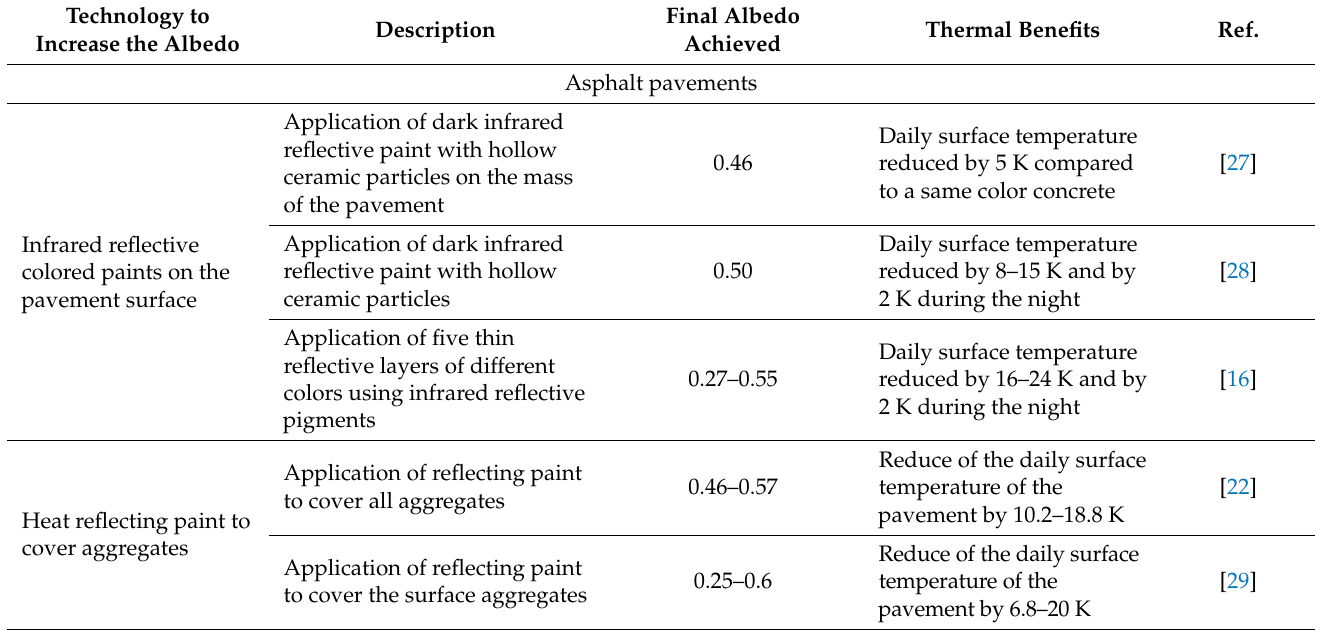
Table 1. Technological trends in the field of reflective pavements (extracted from Santamouris et al. [5]). Technology to Increase the Albedo